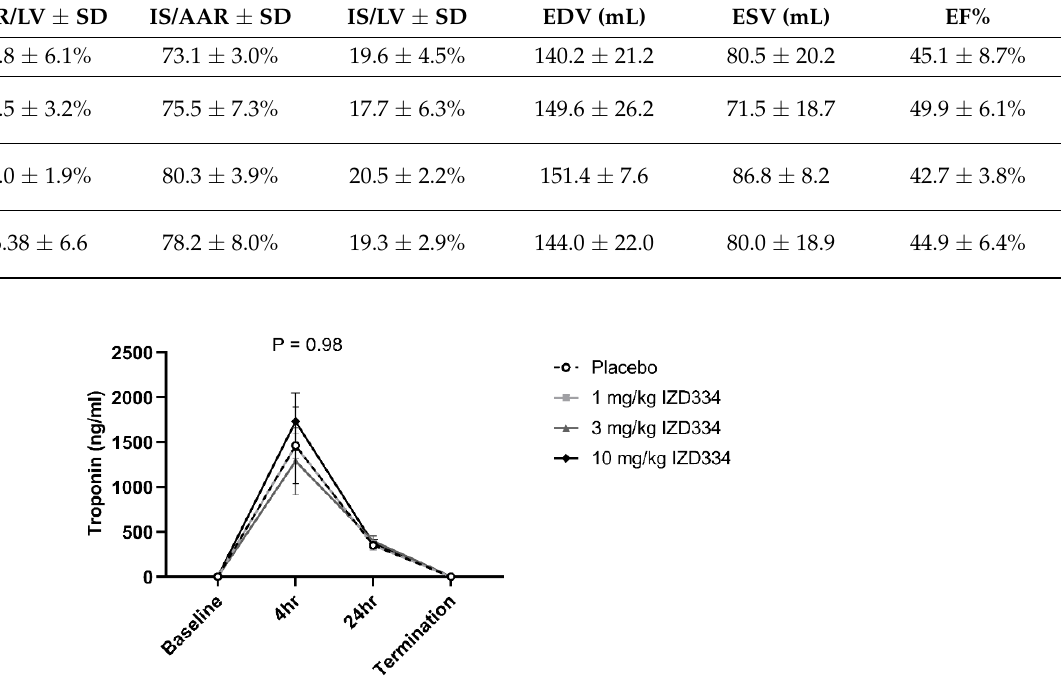
Figure 6. Myocardial infarct size. Normal distribution of data was confirmed as described in our